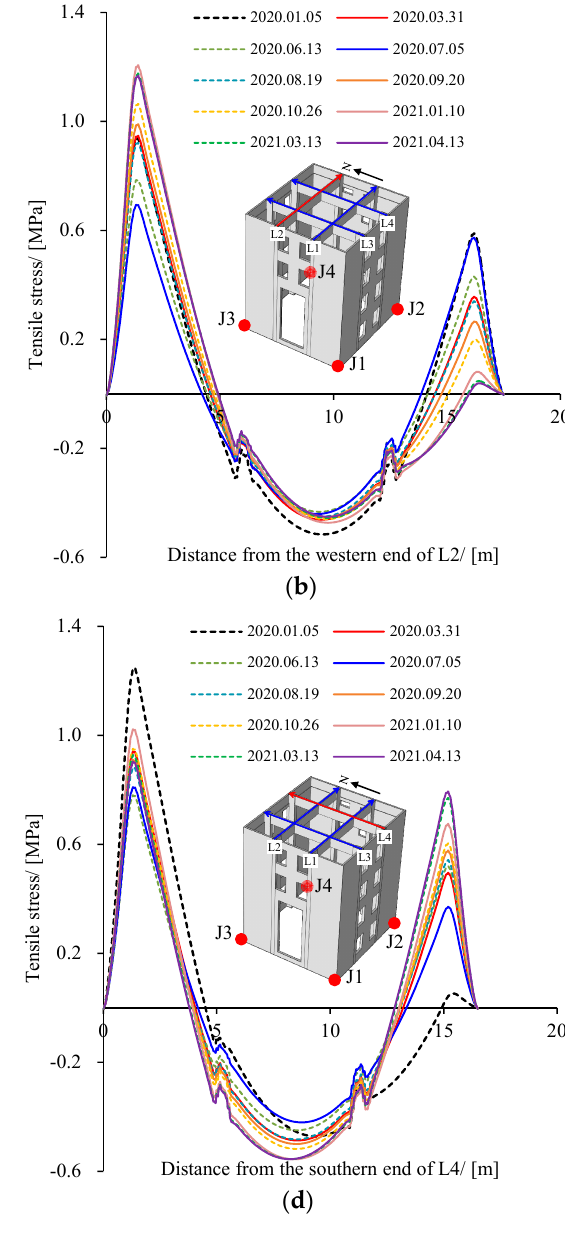
Figure 8. Tensile stress curves on the upper surface of the first − storey concrete main beams in the shaft tower. ( a ) survey line L1; ( b ) survey line L2; ( c ) survey line L3; ( d ) survey line L4.